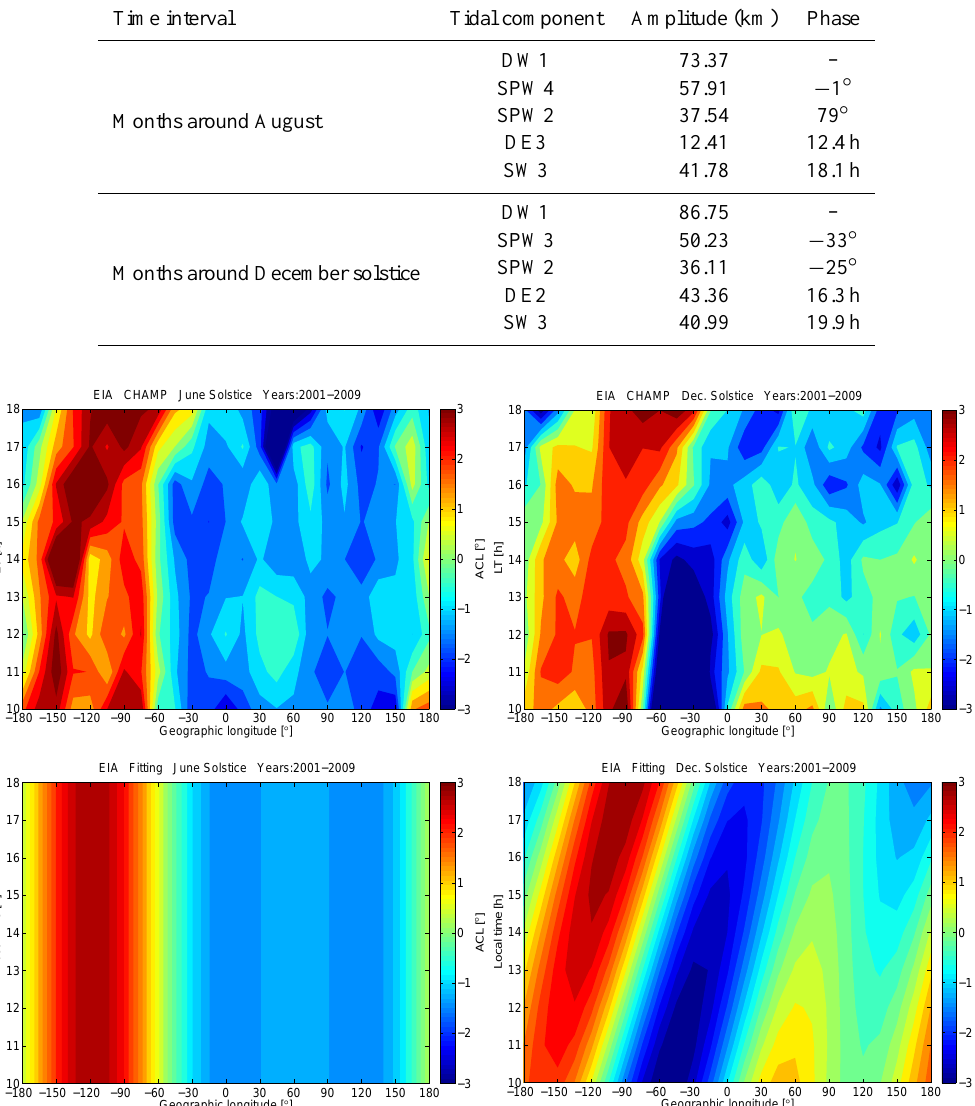
Table 1. Amplitudes and phases of the most prominent tidal components contributing to the modulation of ApexHC during the months around August and December solstice.